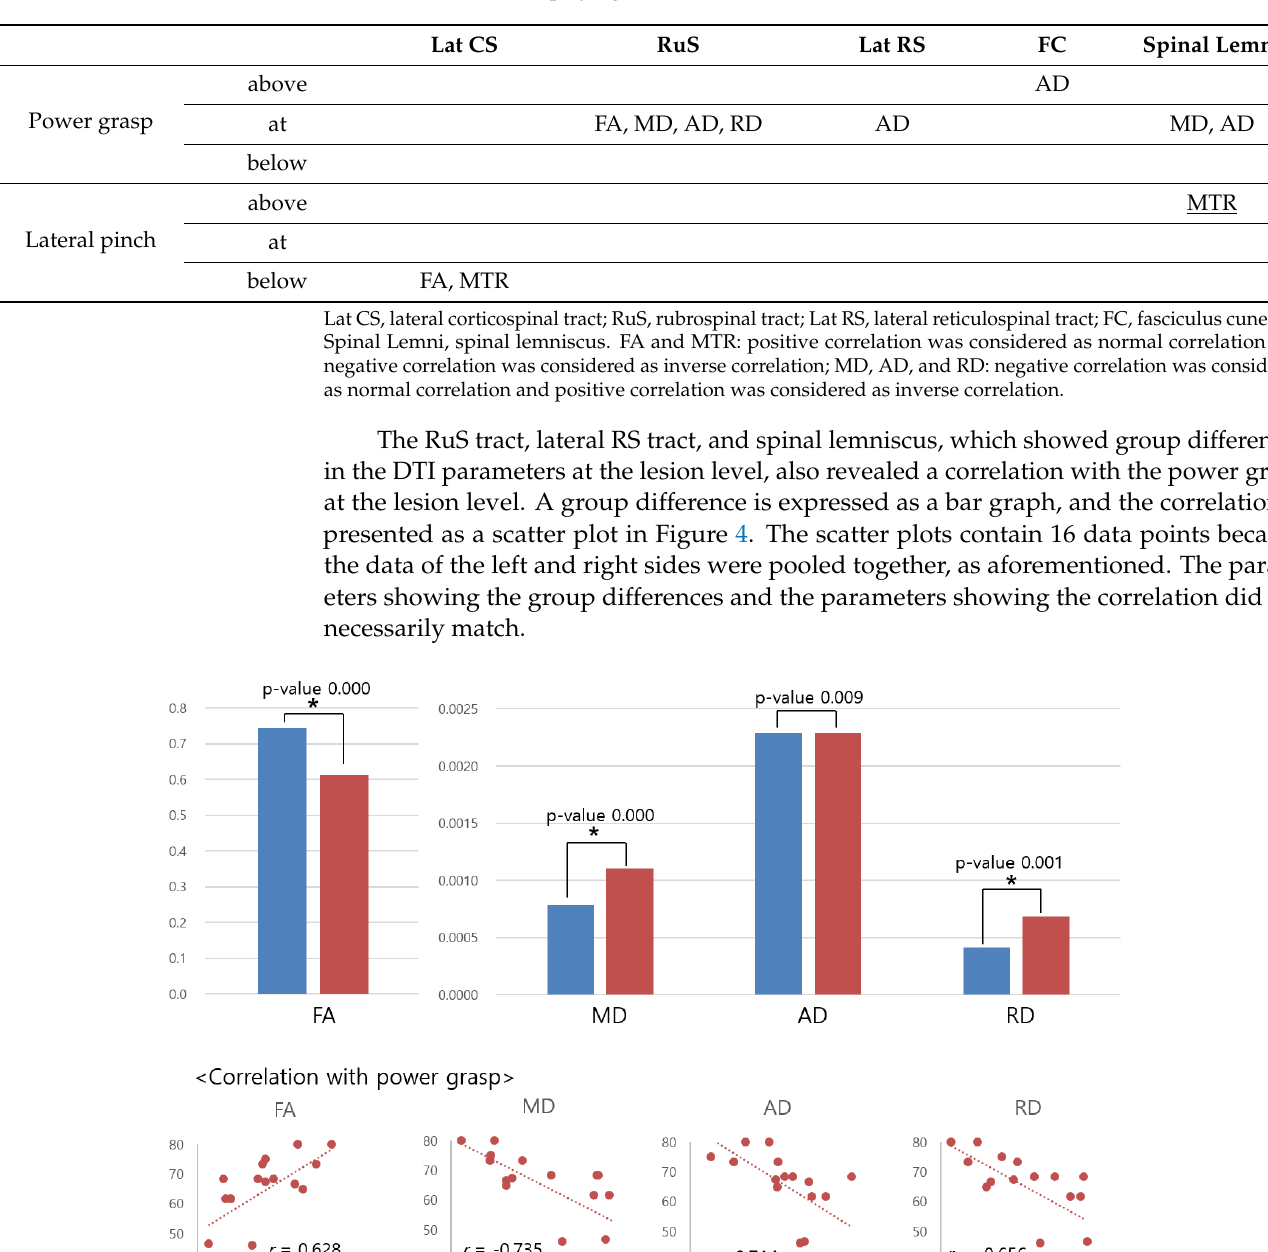
Table 4. MR metrics displaying correlation with clinical items. Underline denotes an inverse correlation.